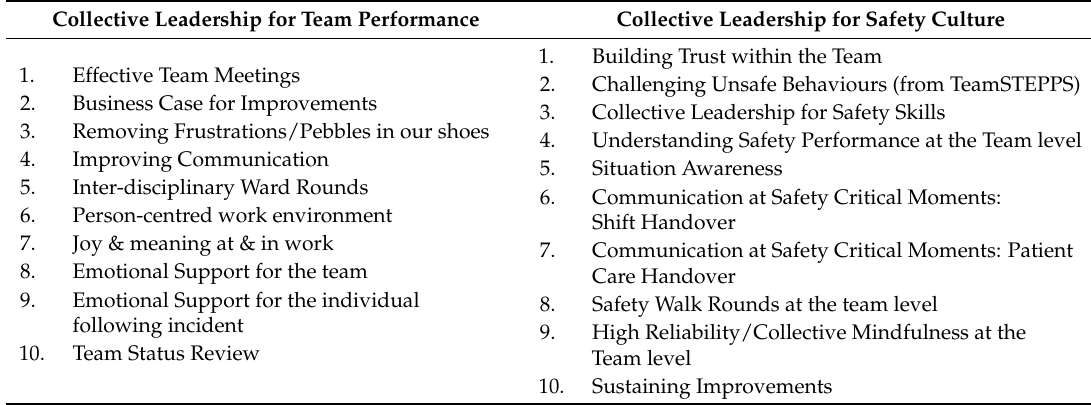
Table 2. List of optional team intervention